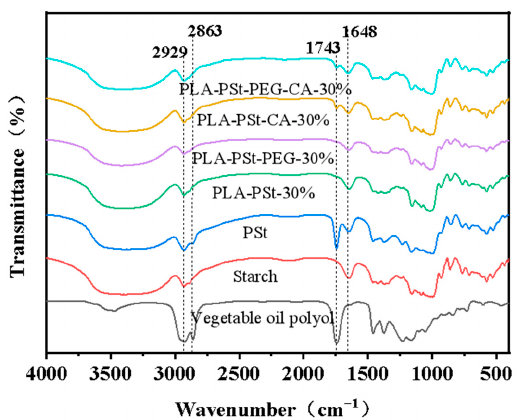
Figure 6. FTIR spectra of vegetable oil polyols, starch, PSt, and pretreated PLA / PSt, PLA / PSt / PEG, PLA / PSt / CA, and PLA / PSt / PEG / CA blend powder samples.